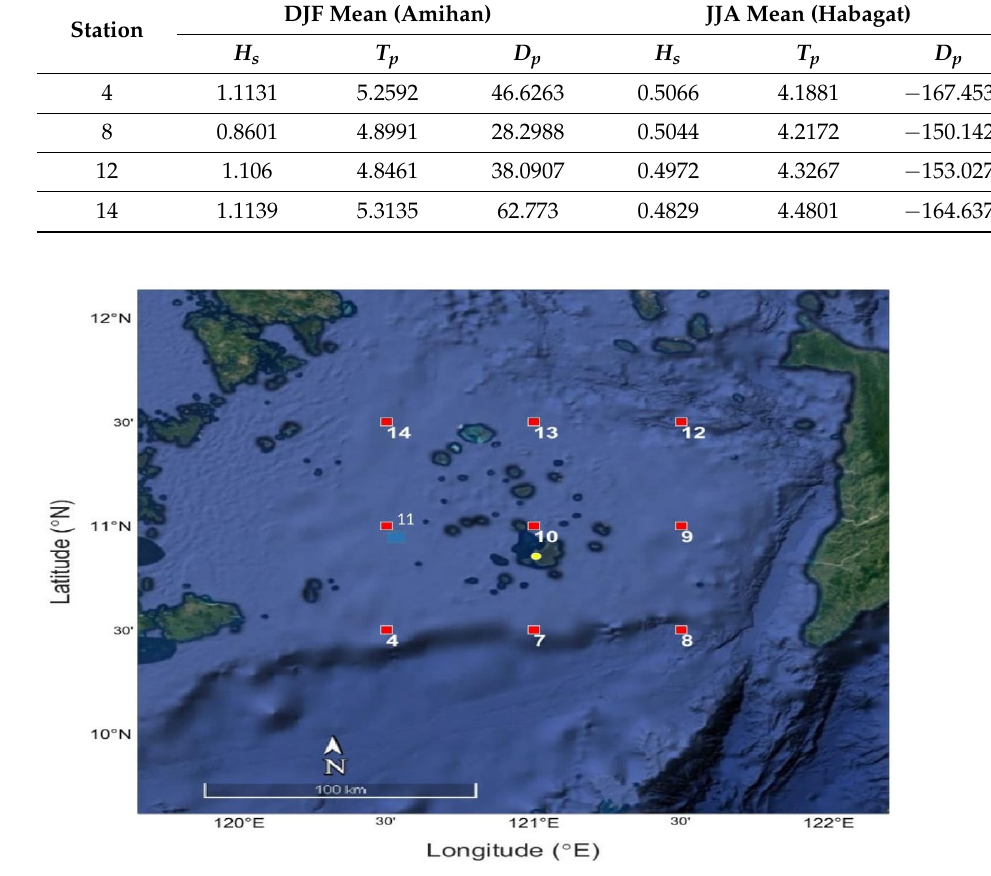
Table 1. Mean H s , T p and D p from MOV’s 2008–2018 data for the northeast (December–January– February (DJF)/Amihan) and southwest (June–July–August (JJA)/Habagat) monsoons.